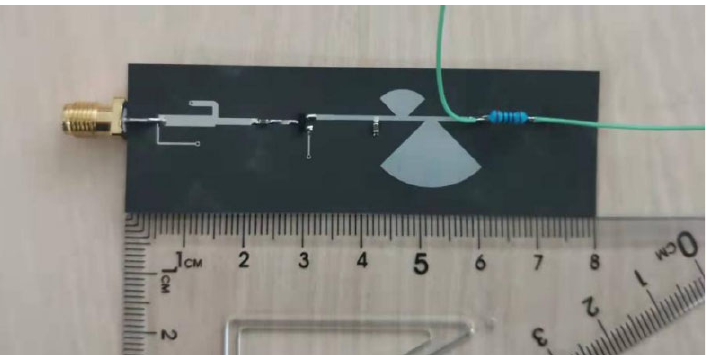
Figure 14. Fabrication of the proposed rectifier.